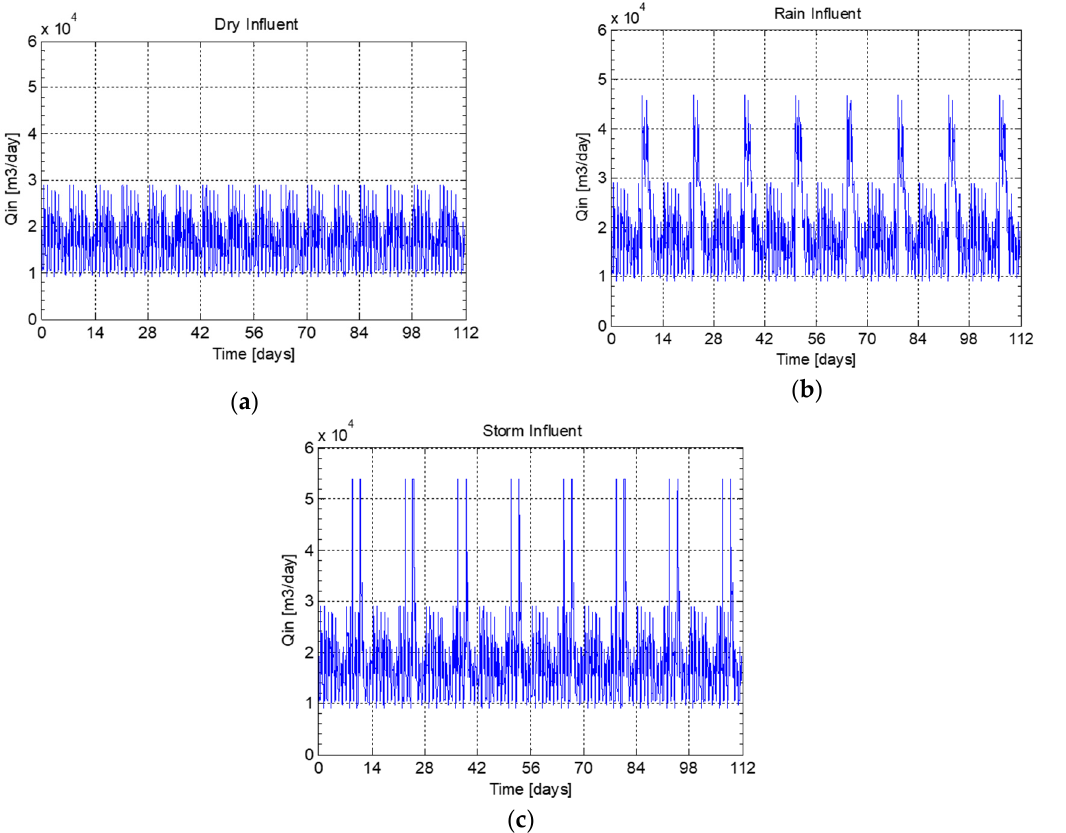
Figure 3. Inflow variations corresponding to the three operation regimes ( a ) DRY; ( b ) RAIN; ( c ) STORM.